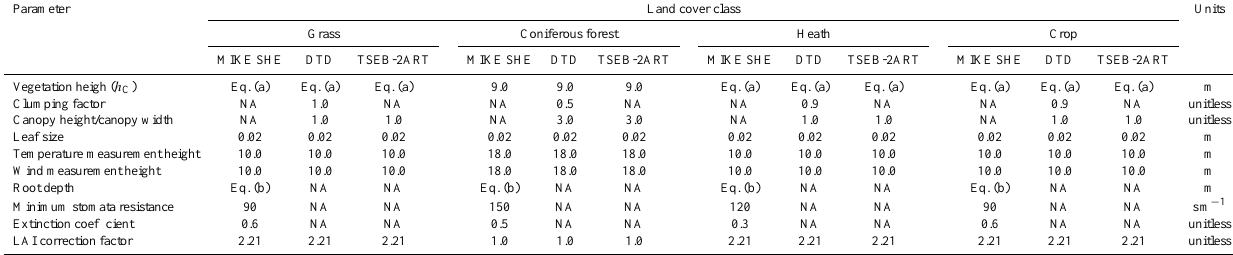
NA Eq.(b) 90 NA NA 150 sm − 1 Extinctioncoefficient 0.6 NA NA 0.5 NA NA